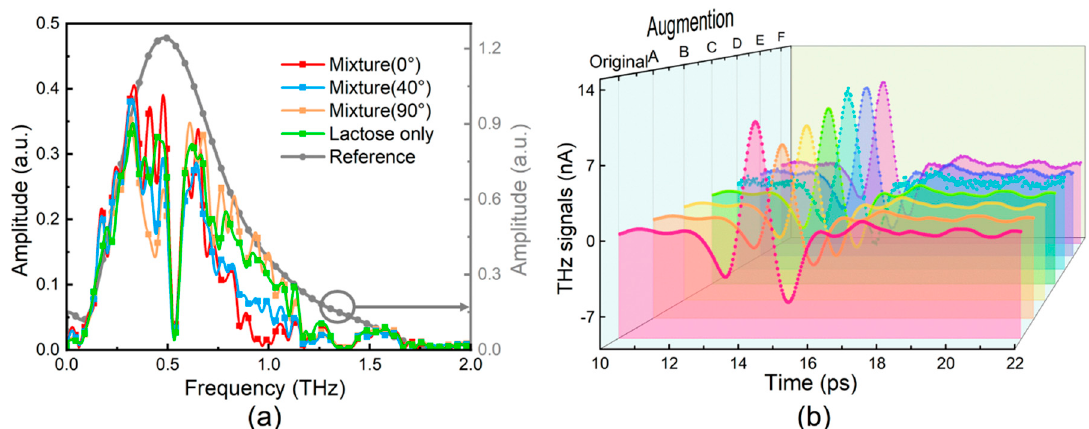
Figure 2. ( a ) Frequency-domain spectra of metamaterial-lactose mixtures with different azimuthal angles of 0°, 40°, 90°, respectively. The grey dotted line is the reference signal without any samples; ( b ) Data augmentation on THz temporal waveform signals. A-F represent signals with attenuation of 70%, 80%, 90%, and signals adding Gaussian noises with mean value 0 and variance 5 × 10 − 9 , 10 − 9 , 10 − 10 , respectively.